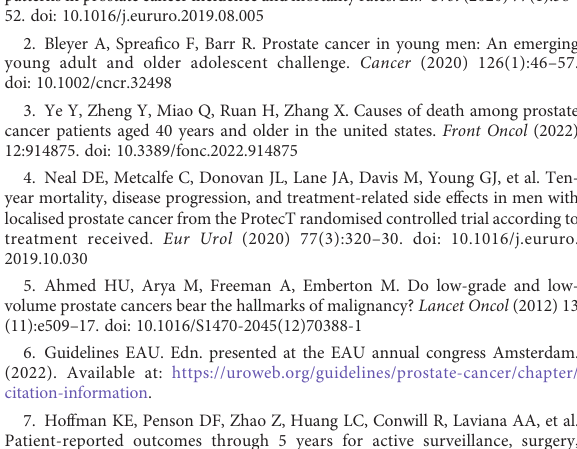
SUPPLEMENTARY FIGURE 1 Intra-procedural MR images of the patient case (presented in Figure 2) undergoing salvage whole-gland TULSA for locally recurrent PCa after radiotherapy. On the top row, axial T2-weighted treatment planning images from all transducer elements (E1-E10) of the transurethral UA. The drawn yellow boundary on the prostate capsule (E3-E7) displays the target ablation area. On the second and third rows, maximum temperature and thermal dose images show a lethal minimum temperature of 55°C and a thermal dose of 240 CEM at 43°C covering the target area. On the fourth row, post-treatment contrast-enhanced images show the non-perfused volume with the rim of enhancement covering the target area. CEM, cumulative equivalent minute;